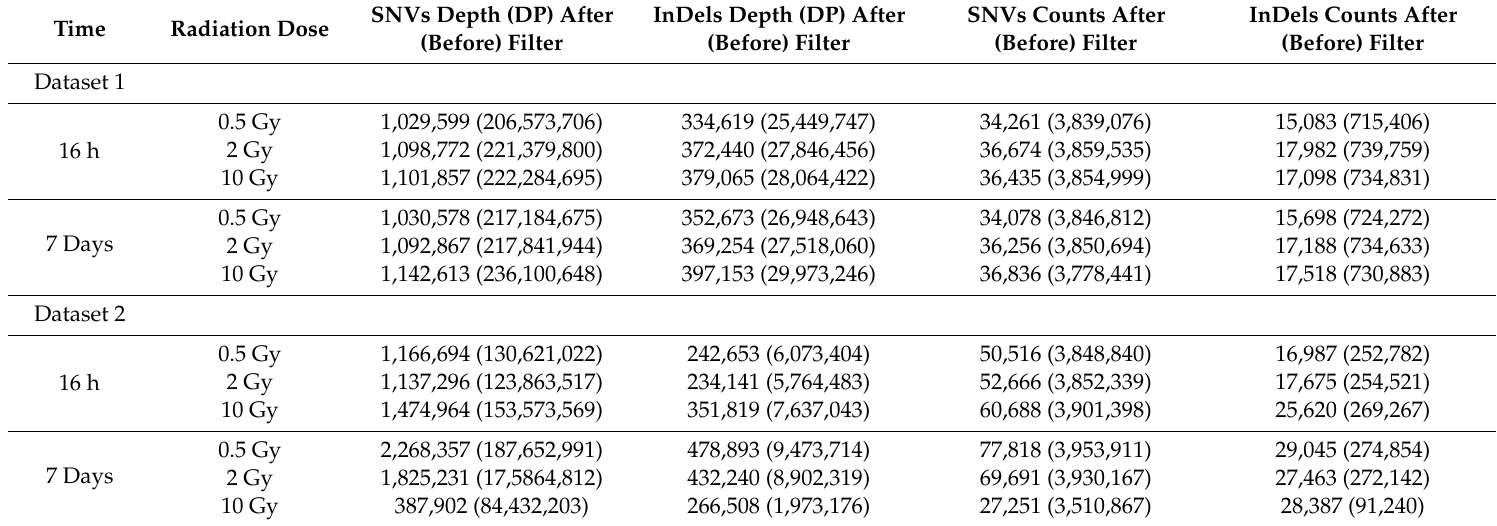
Table 2. Table reporting the depth (DP) and variant counts after and (before) filtering